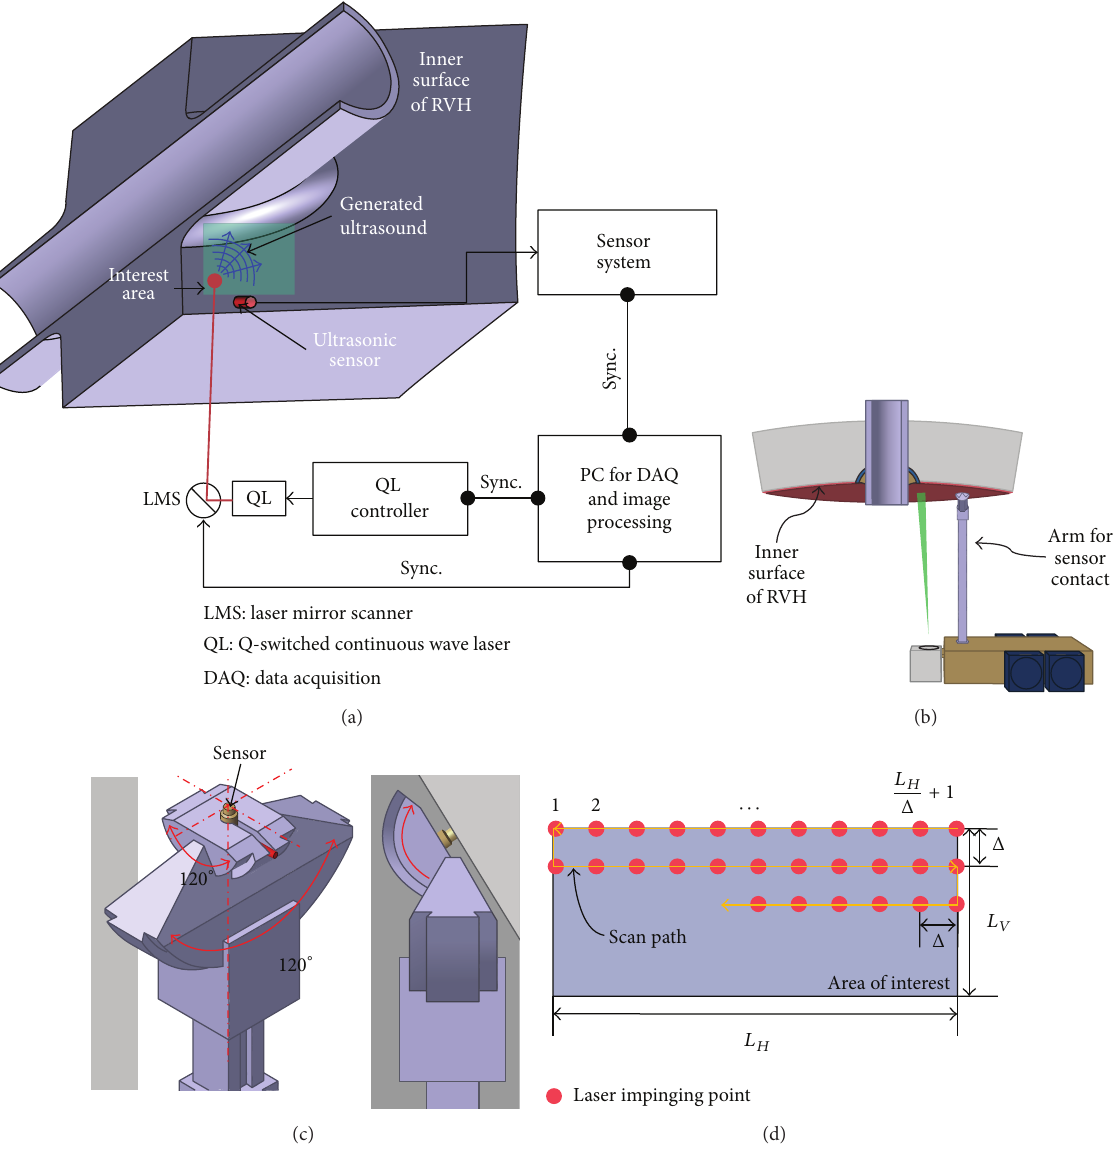
Figure 3: (a) Schematic diagram of ultrasonic propagation imaging (UPI) system for CRDM assembly inspection, (b) schematic diagram for real-world application of the developed system, (c) sensor contact mechanism, and (d) scan path on the area of